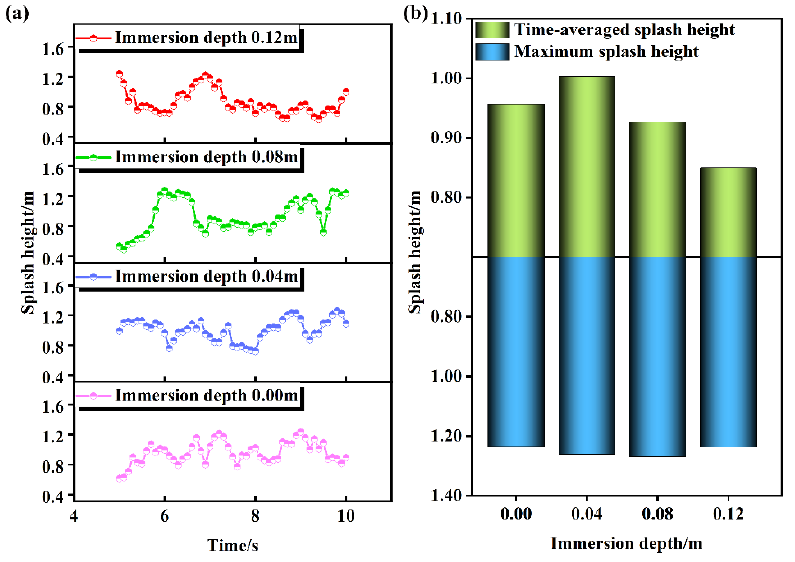
Figure 8. Splash height at different immersion depths ( a ) instantaneous distribution of splash height; ( b ) time-averaged splash height and maximum splash height.